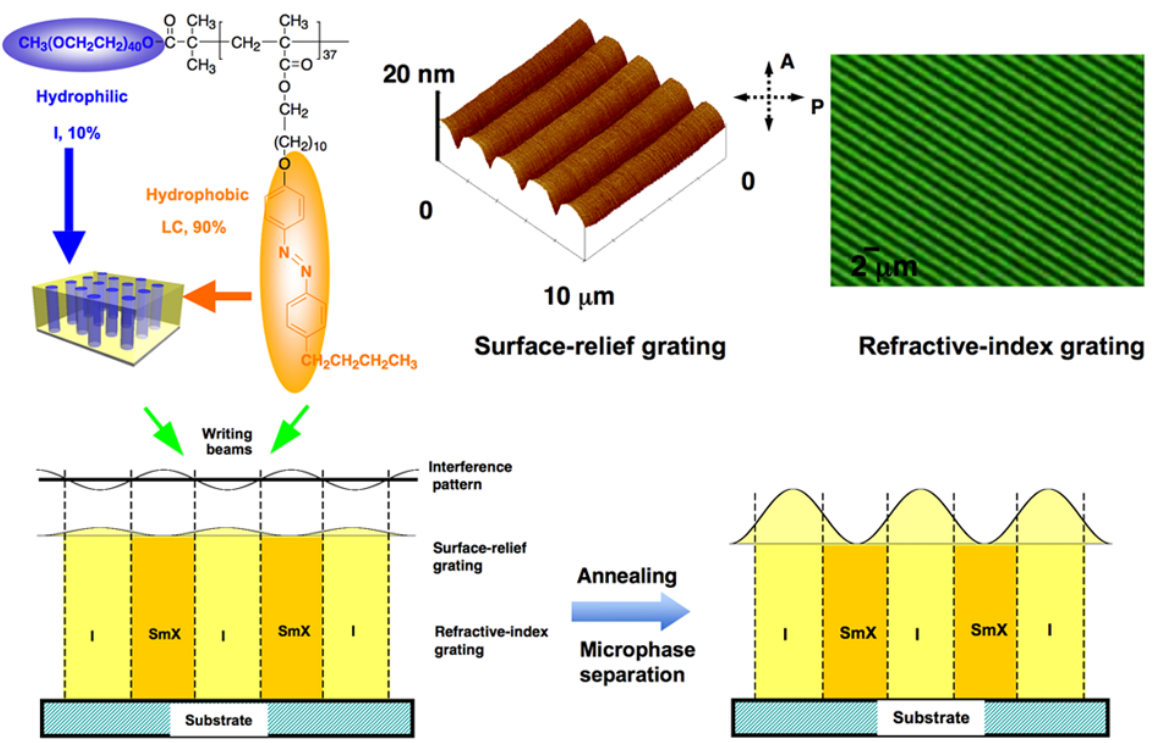
Figure 17. Holographic gratings recorded in PRBCs and enhancement of surface relief upon microphase